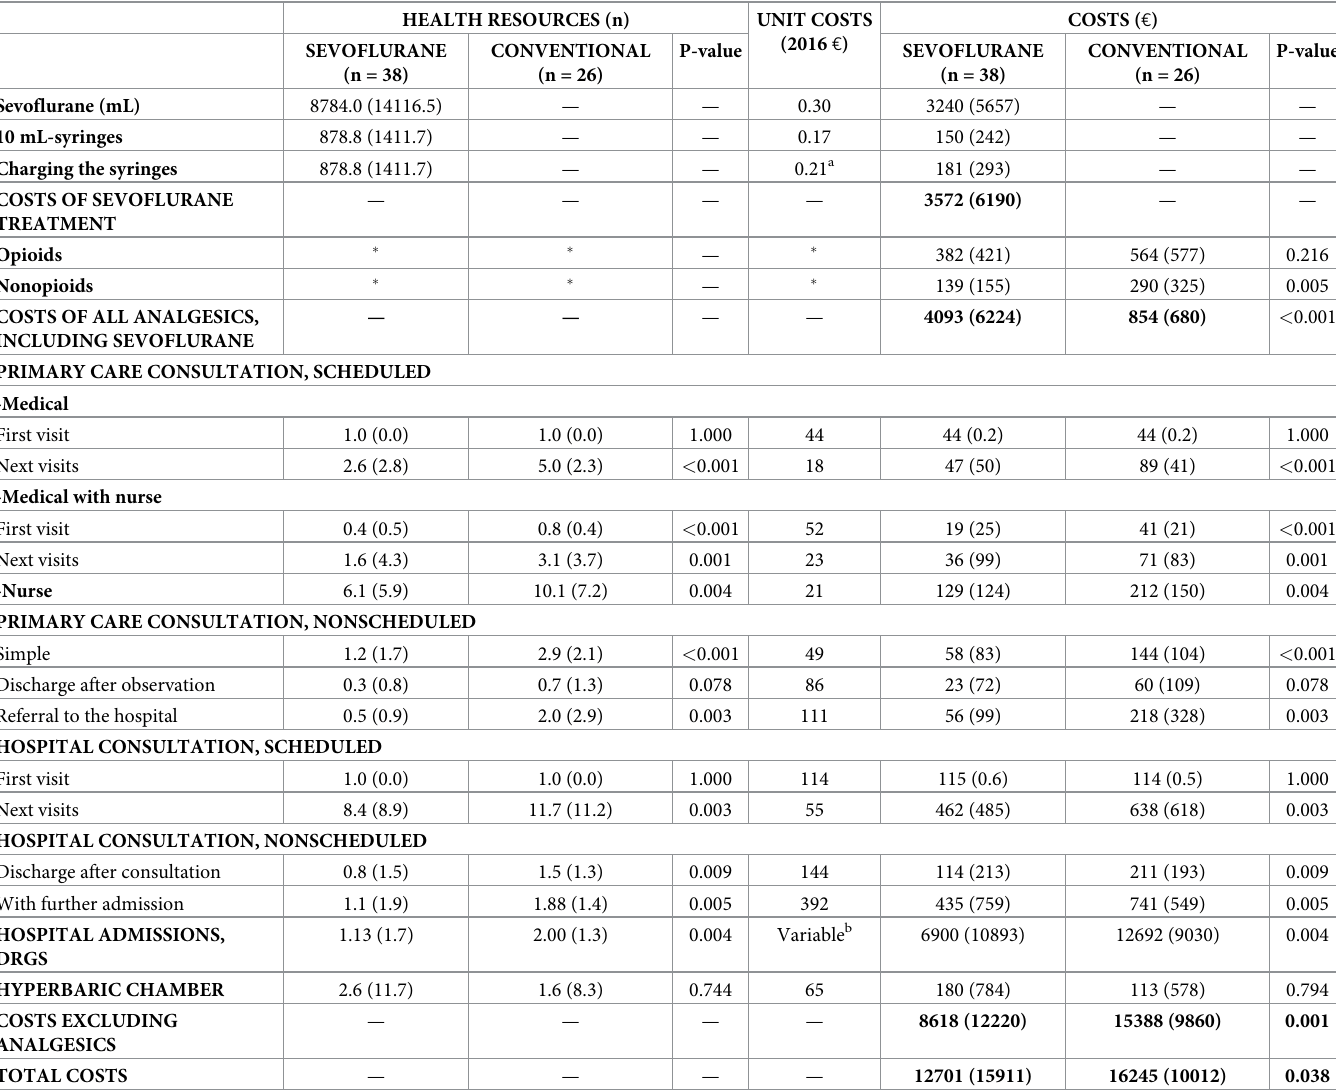
Table 3. Health resources with their unit costs and associated total health